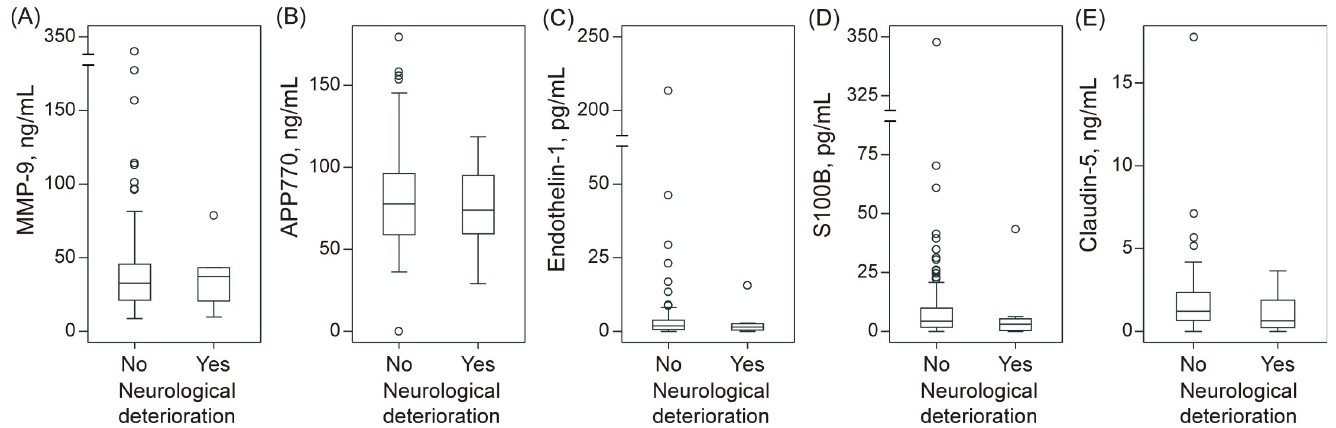
Fig 4. Association between neurological deterioration and biomarkers. There was no significant association between neurological deterioration and the levels of serum biomarkers. APP for amyloid precursor protein; MMP-9, matrix metalloproteinase-9.